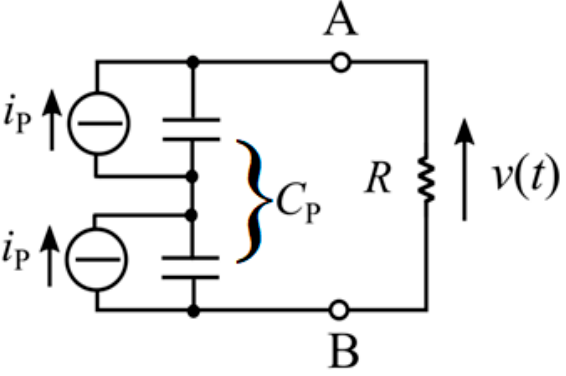
Figure 12. Electrical model of the piezoelectric energy harvester.